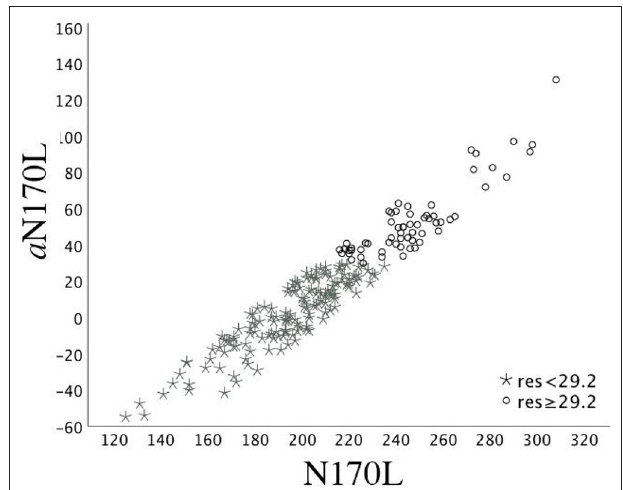
FIGURE 1 | Time 1 N170L and a N170L for the ASD group. Relation between the raw Time 1 N170L (x-axis) and the age-adjusted N170L (aN170L)(y-axis) in response to upright faces. Children with ASD and slowed age-adjusted N170s are identified by black open circles; Children with ASD and standard age-adjusted N170s are identified by gray stars. The use of the residual cutpoint of > 29.2 reflects the ASD sample overlap with 10% of the TD